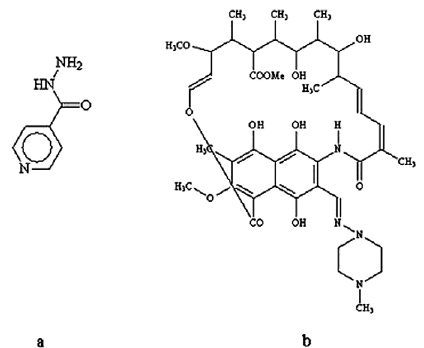
FIGURE 1 – Molecular structures of isoniazid (a) and rifampicin (b).